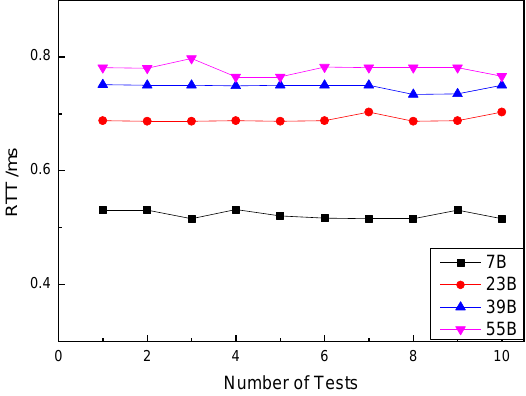
Figure 9. Relationship between RTT and payload length.